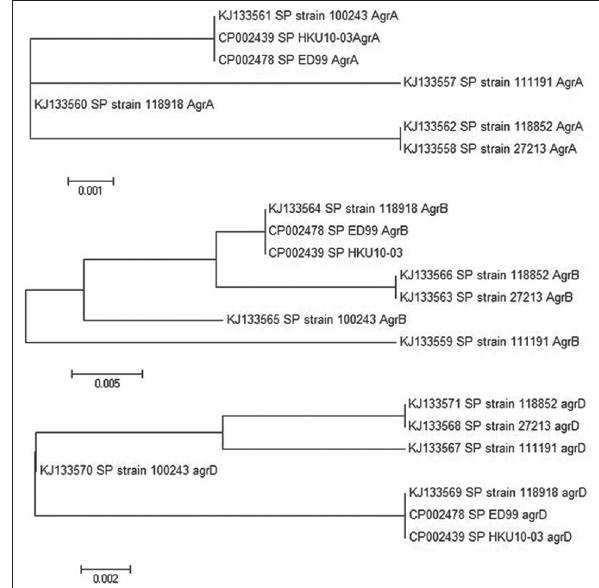
Figure-3: (a-c) Phylogenetic tree based on AgrA, AgrB, and AgrD amino acid sequences of Staphylococcus pseudintermedius